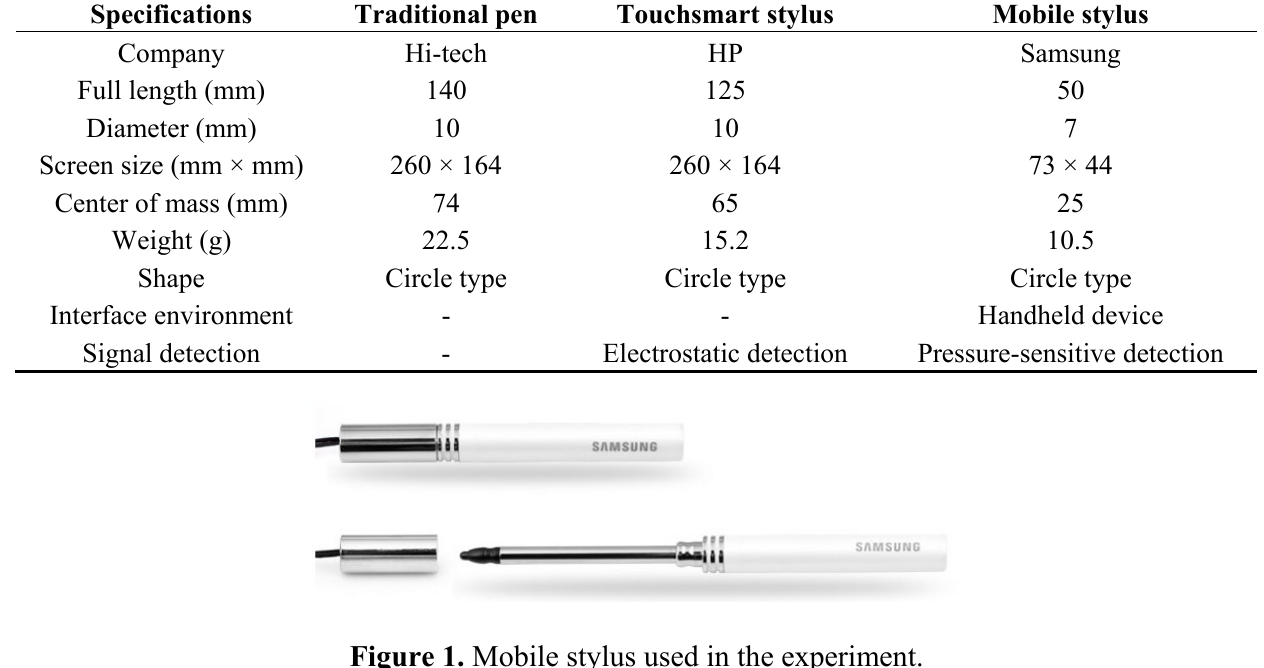
Table 1. The specifications of traditional and stylus pens. Center of mass is the distance from front side.